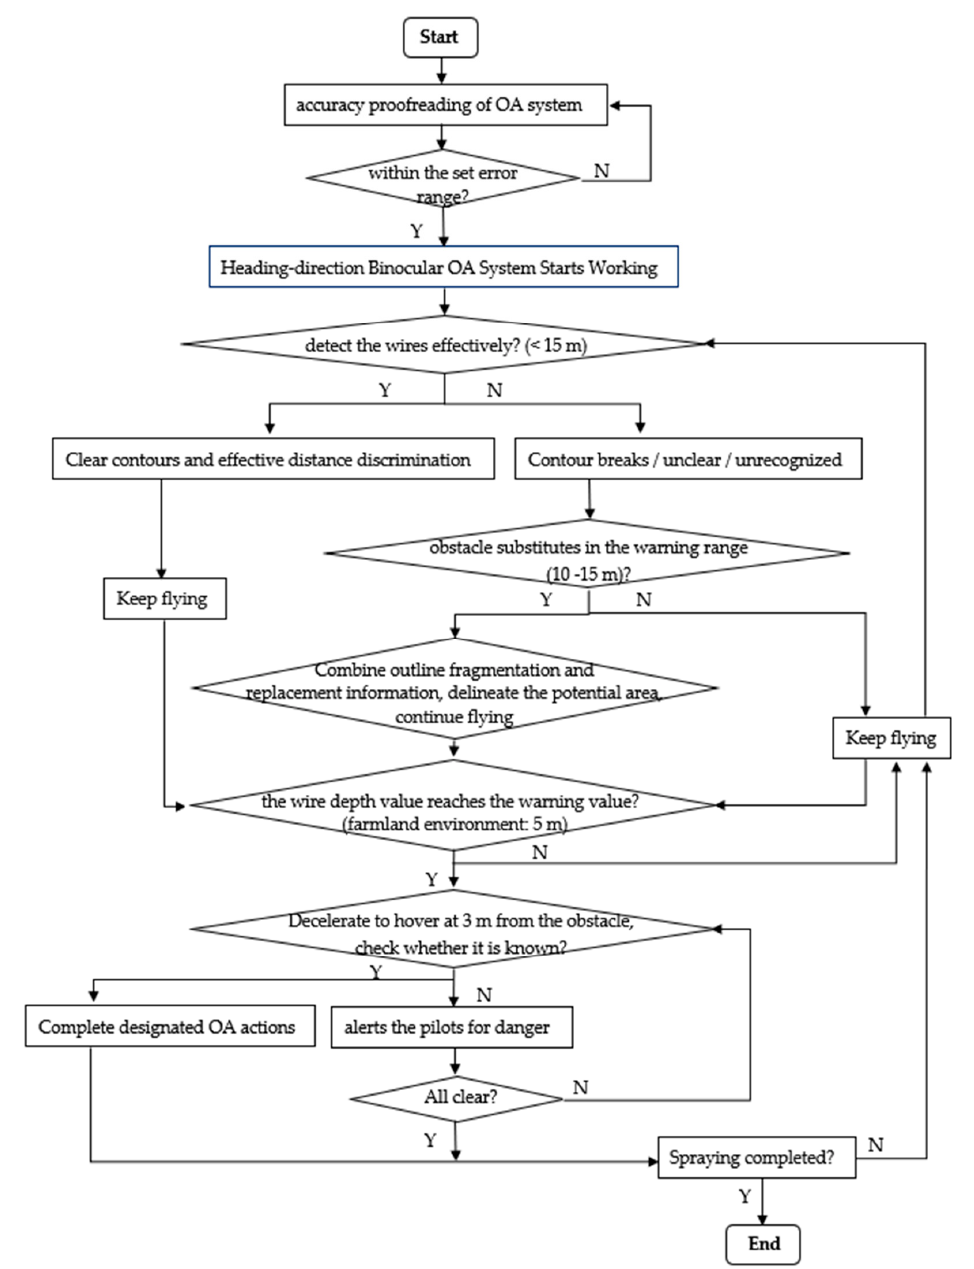
Figure 3. Obstacle avoidance flow chart of micro obstacles for Agricultural UAV based on binocular vision sensor.